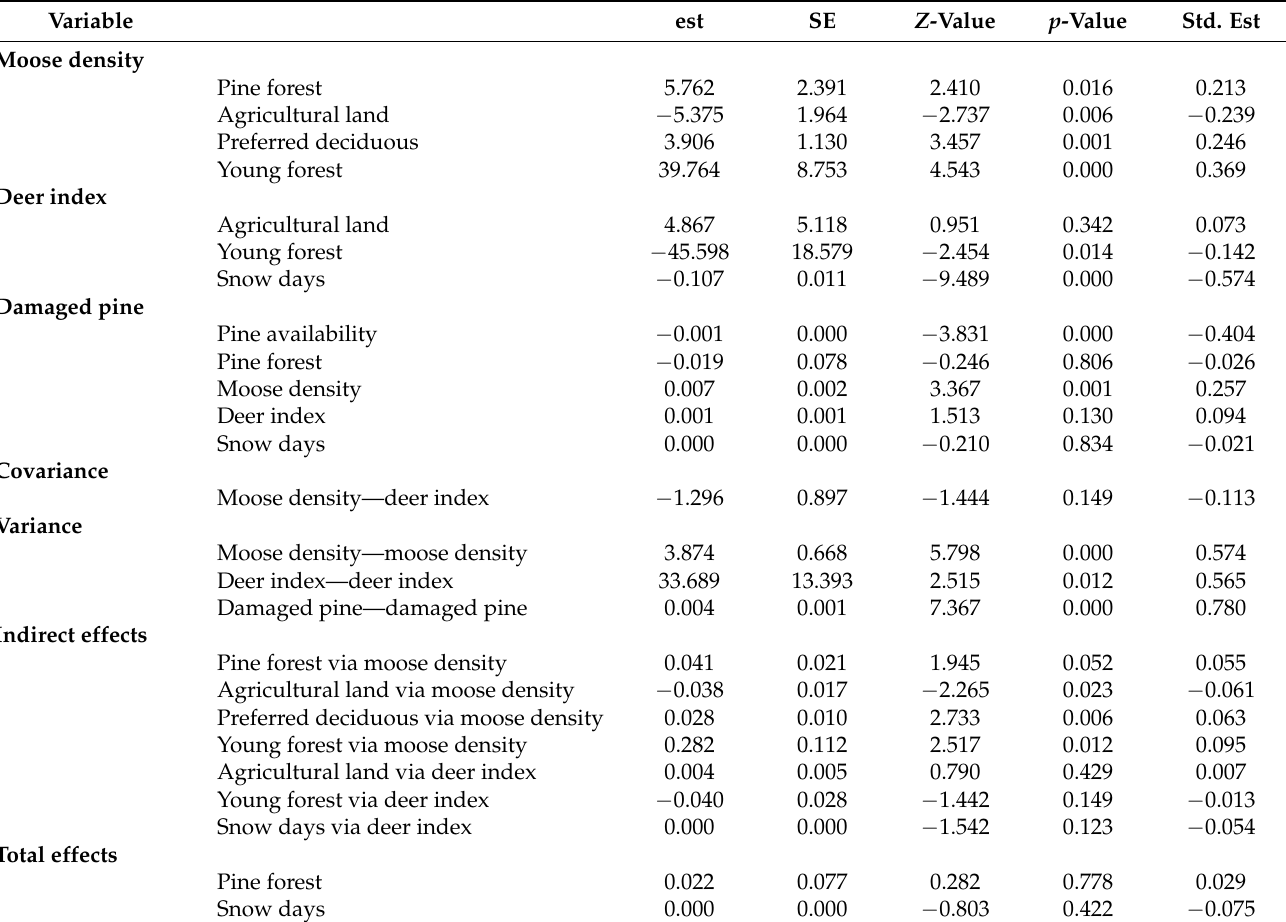
Table 3. Unstandardized parameter estimates (est), corresponding standard errors (SE), outcomes of significance testing ( Z - and p -value) and standardized estimates (std. est) of the national model. The table contains estimates for the path coefficients, followed by covariance estimates between collaboration variables, and variance estimates for all endogenous variables. Estimates of indirect and total effects have been calculated; standard errors for these have been computed using the delta method. An equivalent table for the northern model can be found in the Supplementary Material File S2, Table